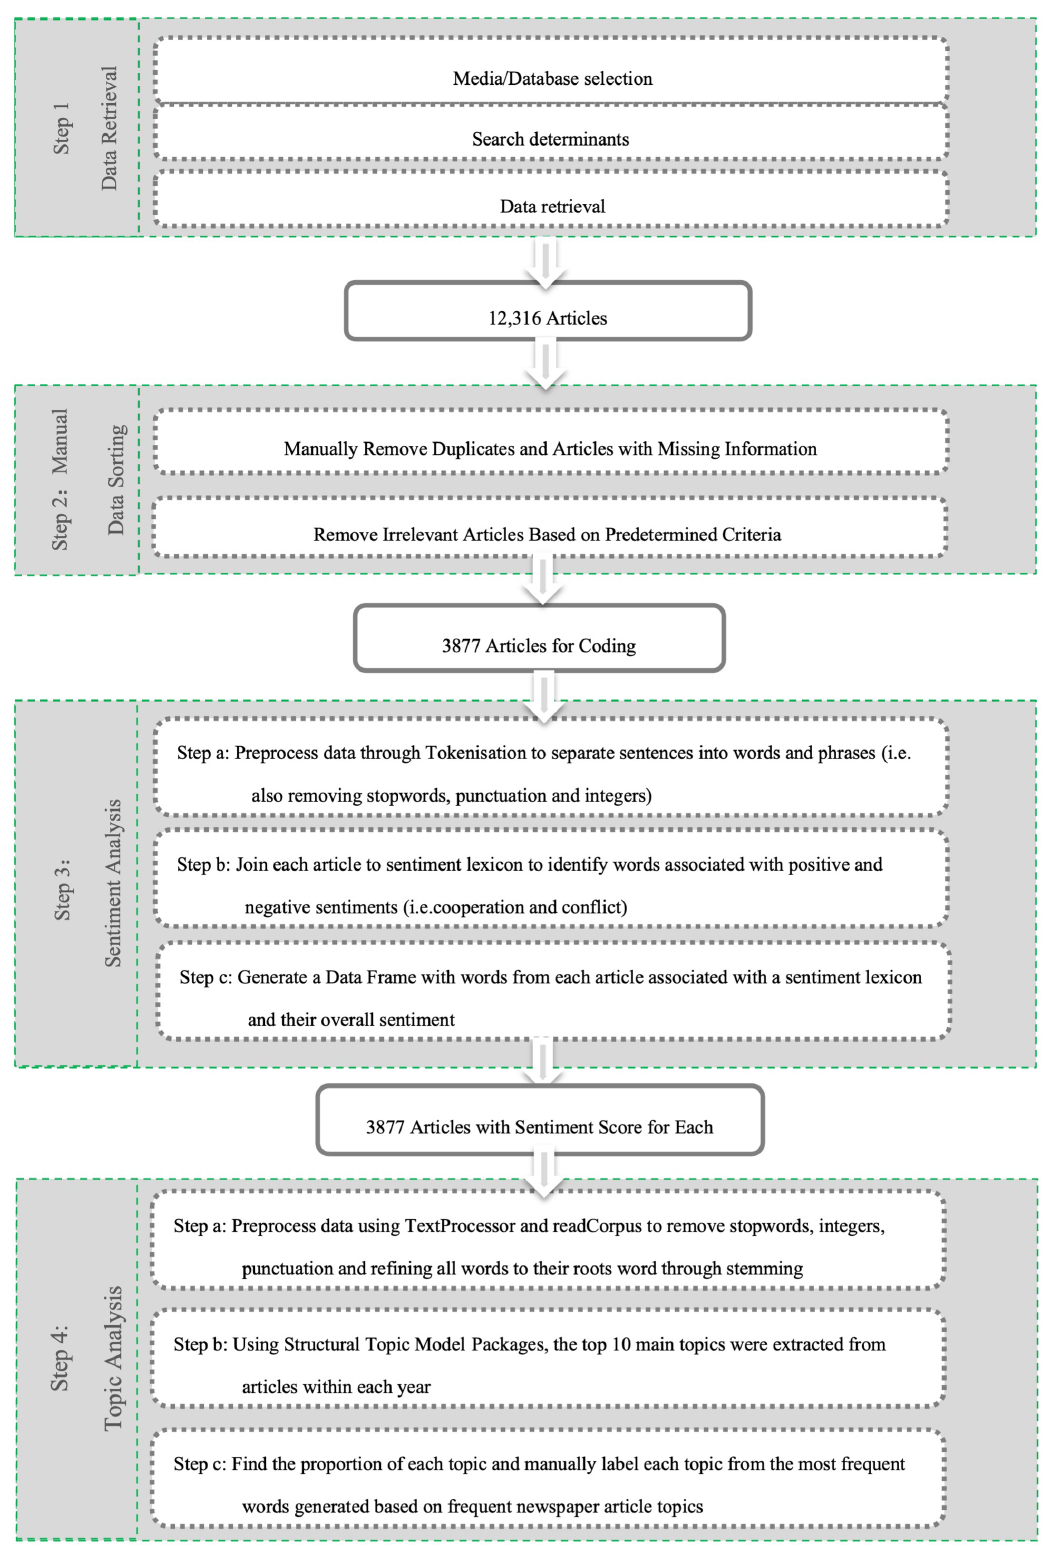
Figure 3. Outline of the data retrieval process and coding for sentiment analysis and the structural topic